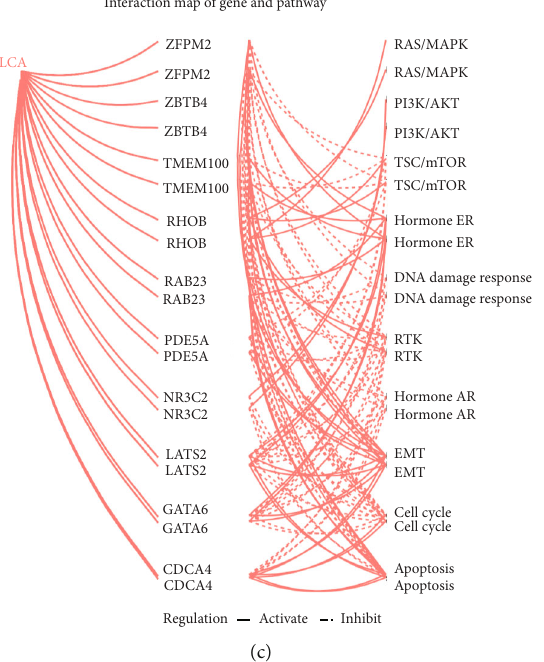
Figure 12: Pathway activity analysis of the hub genes. (a) Global percentage of the hub genes in activating or inhibiting pathways. (b) Heat map of the hub genes with percentage scores. (c) Relation network of the hub genes and